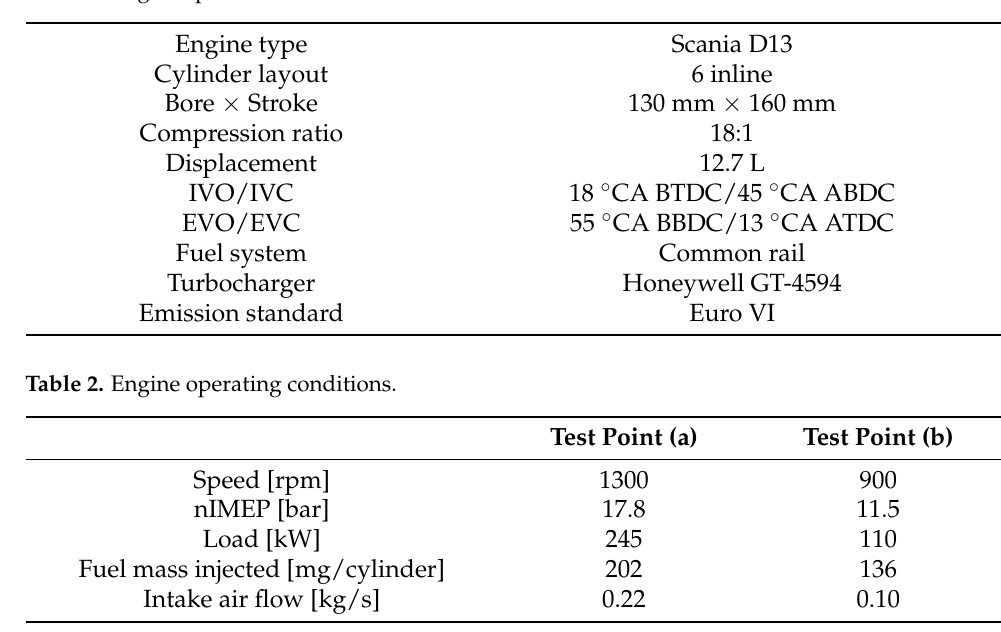
Figure 1. An illustration of three locations (marked as red circles) for obtaining the exhaust pulsation in simulations. The blue squares denote the measuring points of exhaust flow in engine experiments. Table 1. Engine specifications.